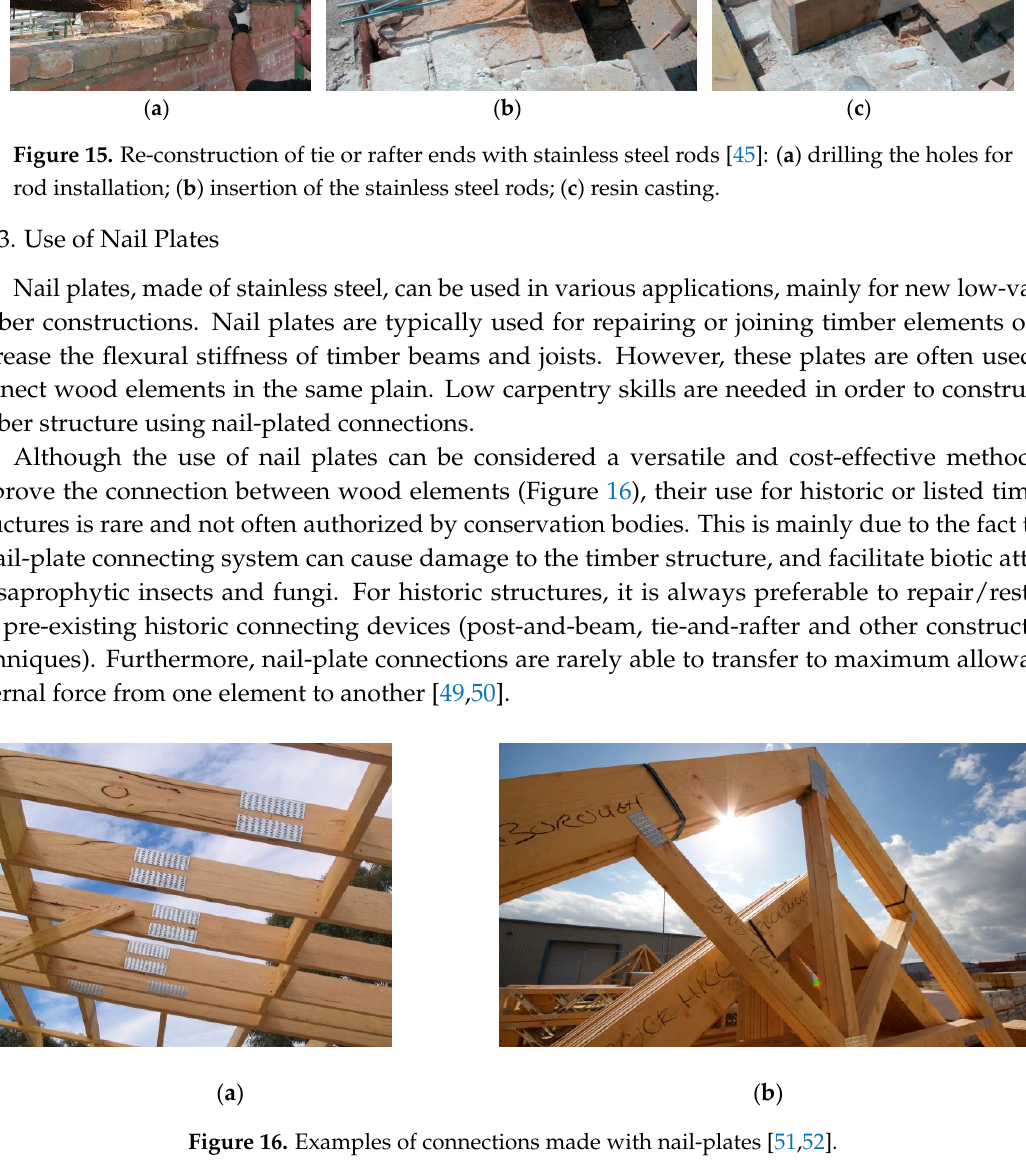
Figure 16. Examples of connections made with nail-plates [51,52].